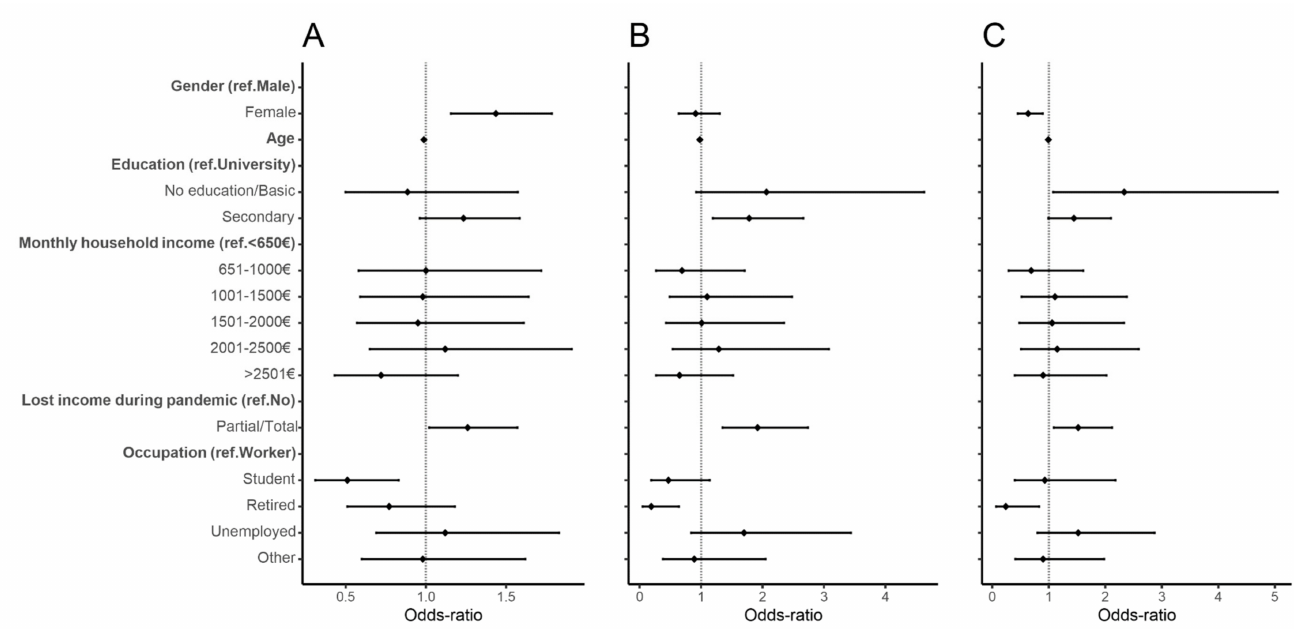
Figure 1. Forest plot of vaccine hesitancy for contextual influences. Adjusted odds-ratio (adjusted for gender, age, education, and period of questionnaire) and the respective 95% confidence intervals are denoted by black dots and black lines, respectively. ( A ) Individuals who would wait to take the vaccine compared to individuals who would take the vaccine; ( B ) individuals who would not take the vaccine compared to individuals who would take the vaccine; ( C ) individuals who would not take the vaccine compared to individuals who would wait to take the